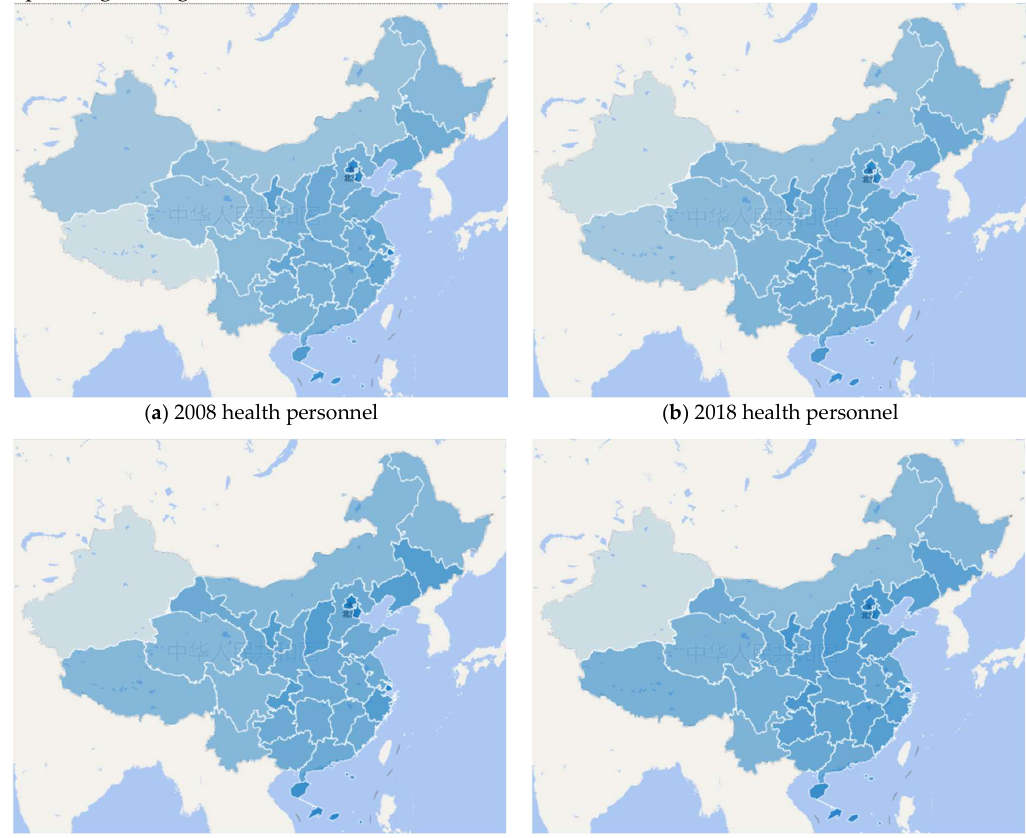
Figure 4. Geographical distribution of public-health resources. Note: (1) ( a , b ) respectively show the geographical distribution of health personnel in 2008 and 2018. And the health personnel is measured by the quantity of health personnel per thousand square kilometers per million people, namely “health personnel / (thousand kilometers 2 • million people)”. (2) ( c , d ) respectively show the geographical distribution of medical and health institution in 2008 and 2018. The medical and health institution is measured by the quantity of medical and health institution per thousand square kilometers per million people, namely “medical and health institution / (thousand kilometers 2 • million people)”. (3) The darker the blue, the more abundant the public-health resources in that area. (4) These figures above are made by the authors, and there is no copyright